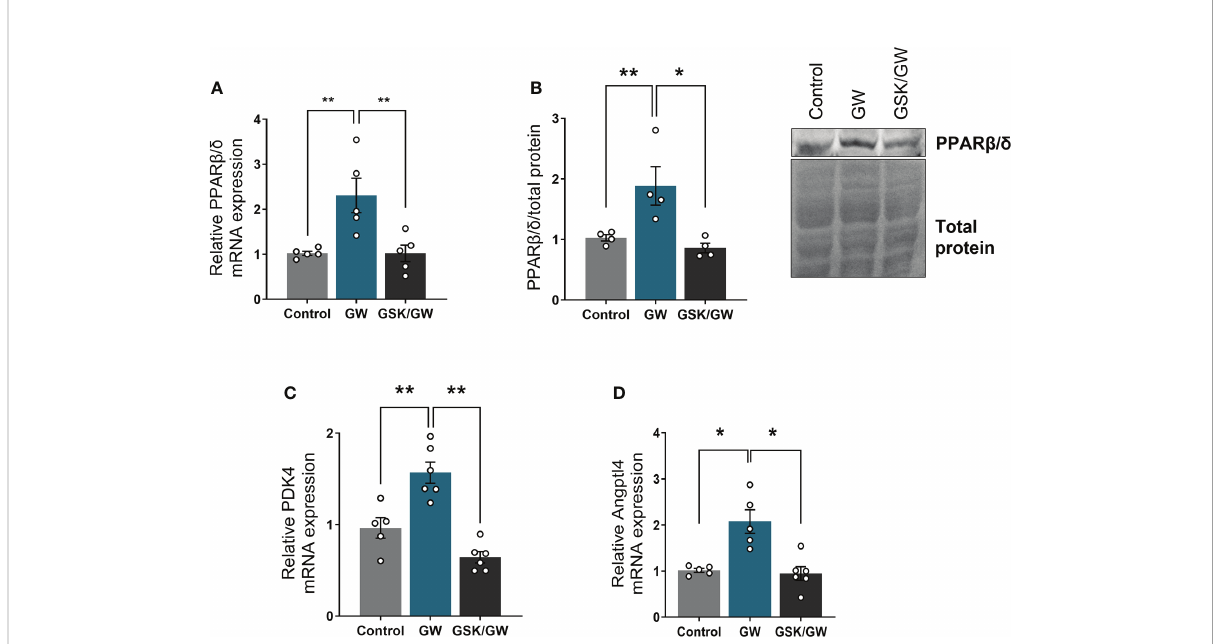
FIGURE 1 PPAR b / d is activated after administration of GW0742. (A) mRNA expression of PPAR b / d was quanti fi ed by qRT-PCR and normalized to b -actin. Results are presented as mean ± SEM of 5-6 independent experiments, (B) Representative immunoblot of PPAR b / d protein (upper panel) and quanti fi cation by densitometric analysis (lower panel). Results are presented as mean ± SEM of 4-5 independent experiments, (C) mRNA expression of PPAR b / d target gene PDK4 and (D) Angptl4 were quanti fi ed by qRT-PCR and normalized to b -actin. Results are presented as mean ± SEM of 5-6 independent experiments. *p < 0.05, **p <